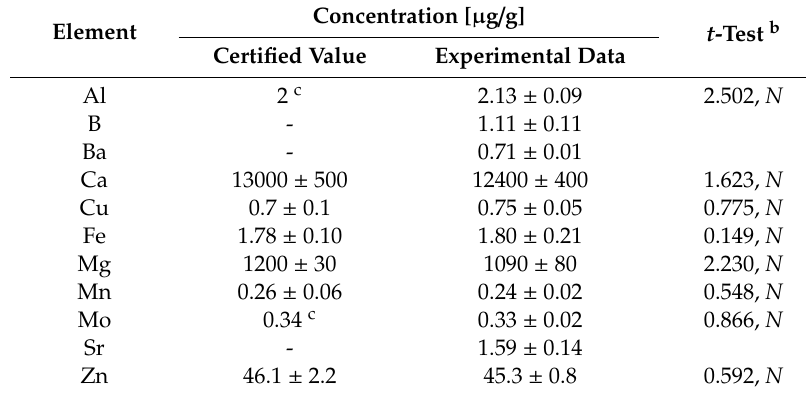
Table 1. Results of element analysis of the non-fat milk powder standard reference material (NIST SRM 1549) a